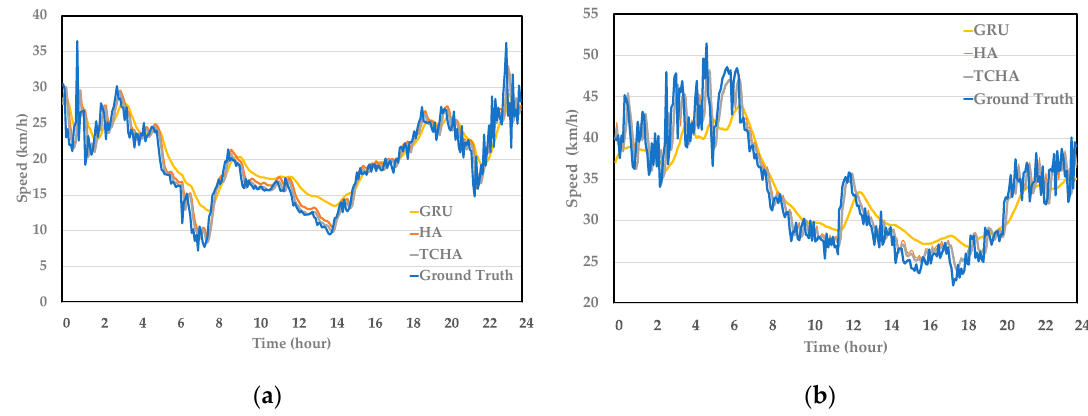
Figure 6. Traffic speed prediction performance. ( a ) Shixin Road and ( b ) Tonghui Road. Figure 6. Tra ffi c speed prediction performance. ( a ) Shixin Road and ( b ) Tonghui Road.